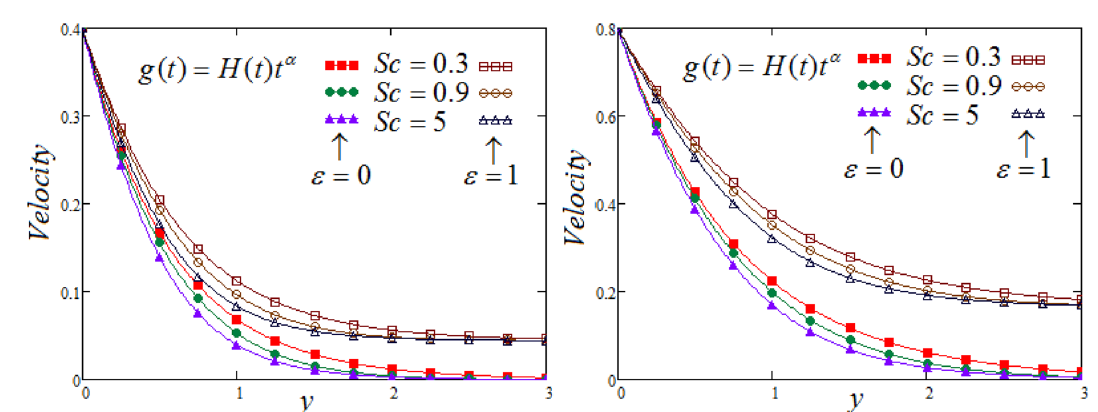
Figure 4. Representation of fluid velocity v ( y , t ) against y for distinct values of Sc with N = 2.5, Pr eff = 4.5, = 0.7, ℘ = π (cid:31) , (cid:31) 2 = 0.3, υ = π , K = 1 , α = 0.7, R 1 6 6